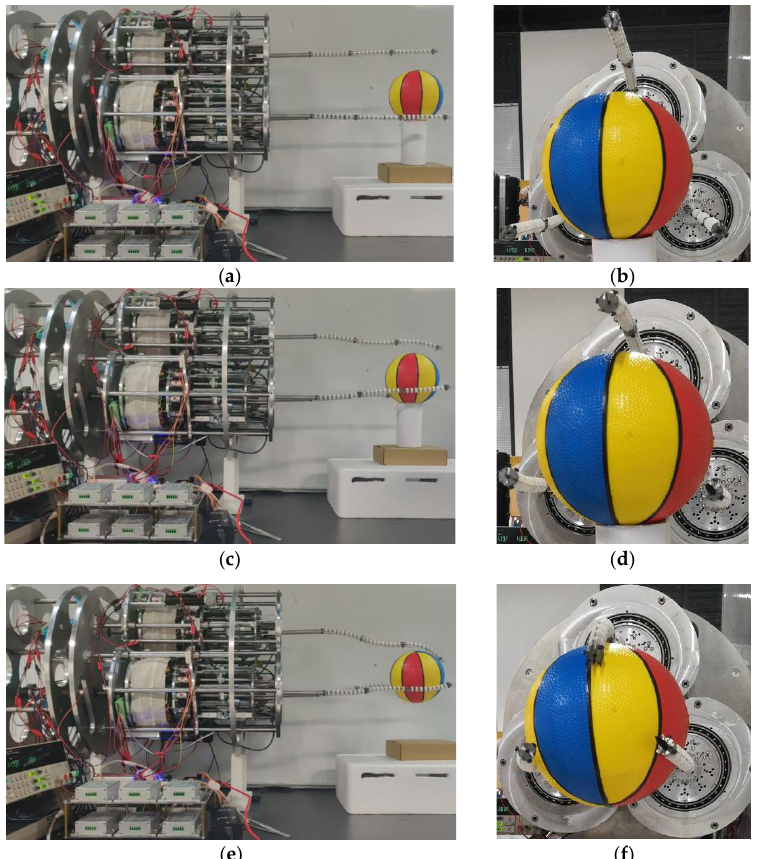
Figure 20. The process of grasping the target ball using the multi-arm space robot. ( a ) Front view of the initial state, ( b ) lateral view, ( c ) front view during grasping, ( d ) lateral view during grasping, ( e ) front view of the final state, ( f ) lateral view of the final state.